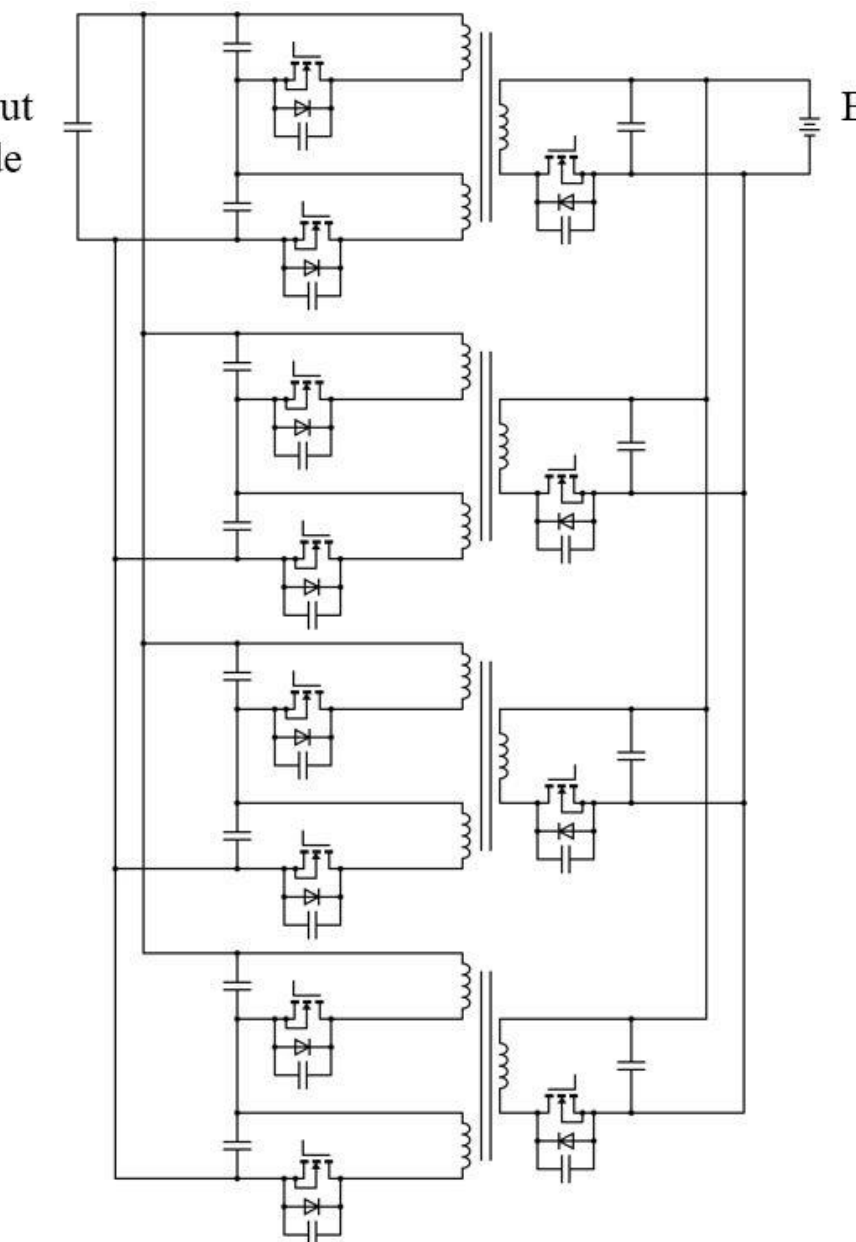
Figure 17. Quasi-resonant interleaved flyback converter [60].